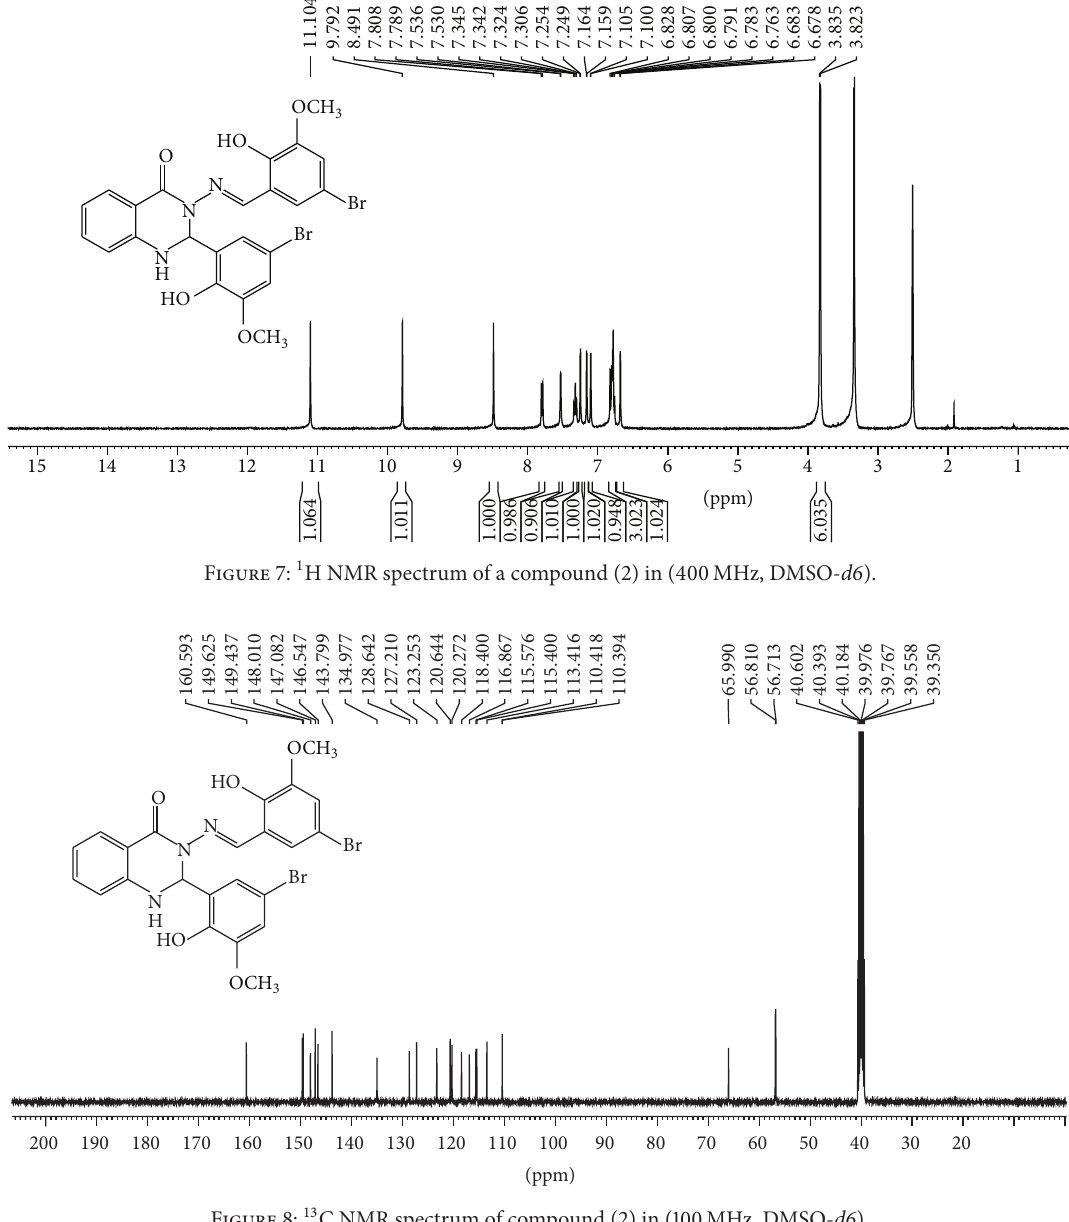
singlet signal appeared in the region of 8.56 ppm for (1) and 8.49 ppm for compound (2) attributed to proton of H-C=N azomethine group [27,